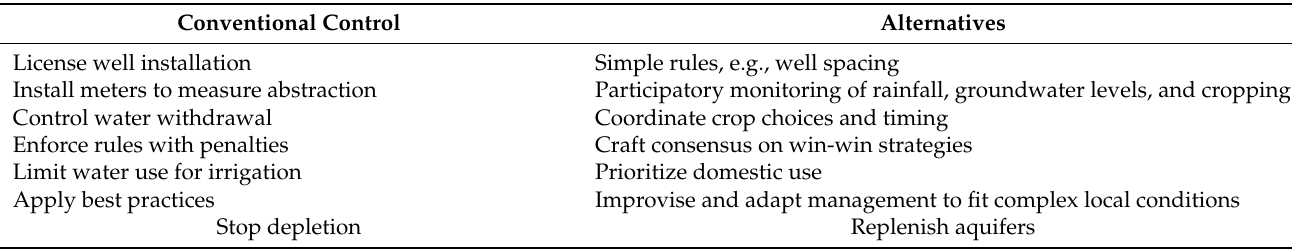
Table 2. Alternatives for polycentric water